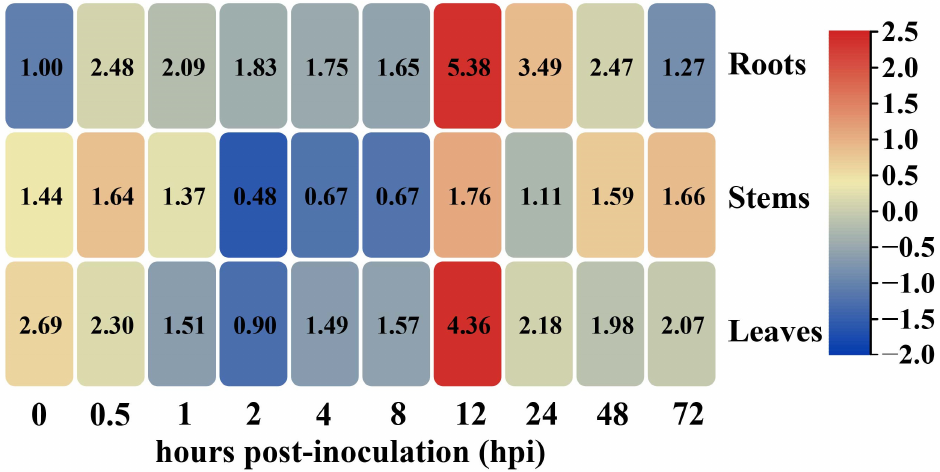
Figure 2. Expression of GhHSFB2a in cotton inoculated with V. dahliae. Heat map analysis of GhHSFB2a gene expressions in different organs (roots, stems, and leaves) and different inoculation time (0, 0.5, 1, 2, 4, 8, 12, 24, 48, and 72 hpi) with V. dahliae of Coker 312 cotton. The color from blue to red indicates low to high expression.